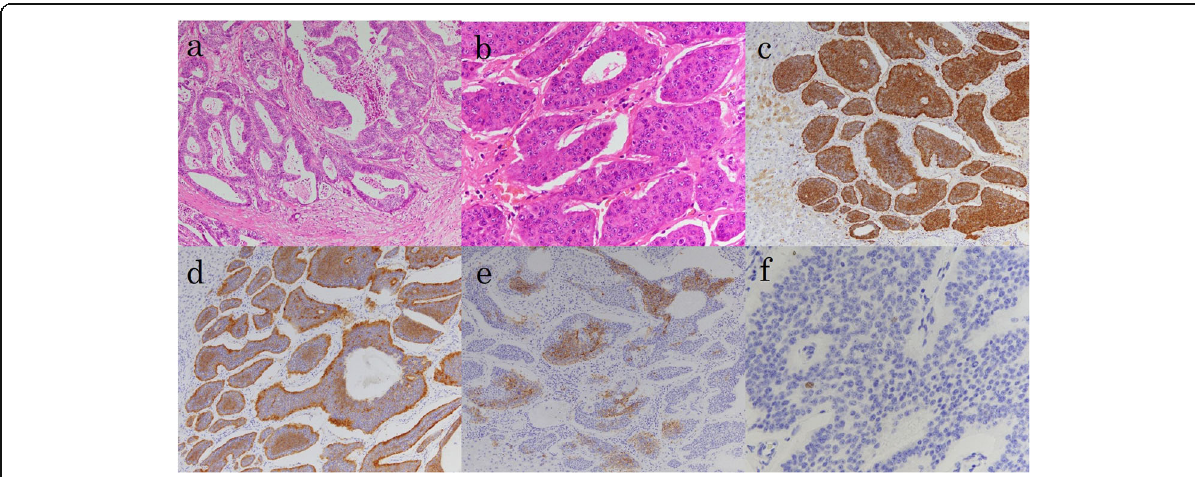
moderately differentiated adenocarcinoma cells, growing in tubular or in a cribriform pattern. b The tumor in segment 6 showed a proliferation of atypical cells with rounded nuclei and eosinophilic cytoplasm that were arranged in a small nested pattern, accompanied by